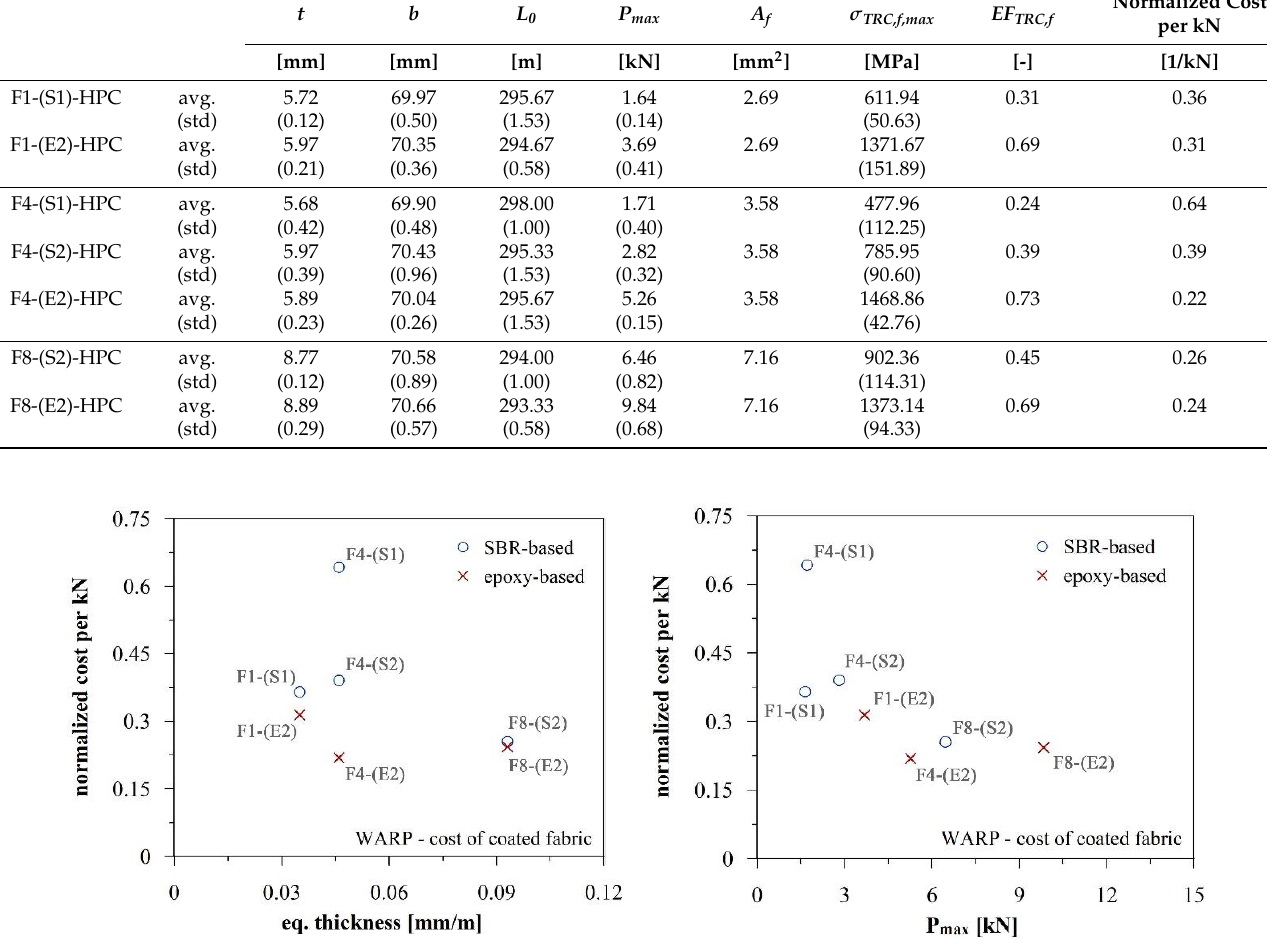
tion of the equivalent thickness of the fabrics and of the maximum load recorded during